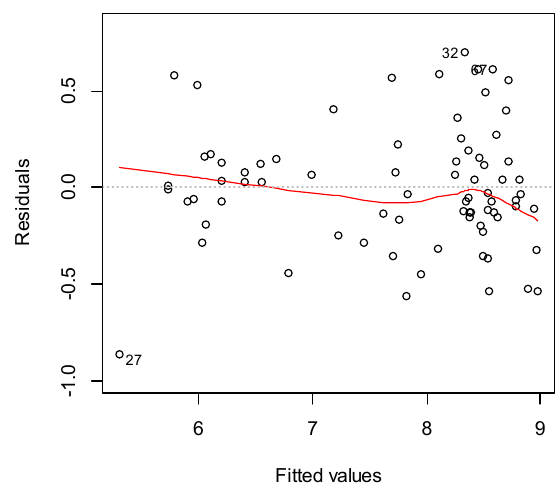
Figure 4. QQ-plot for the obtained model: soluble AOX.